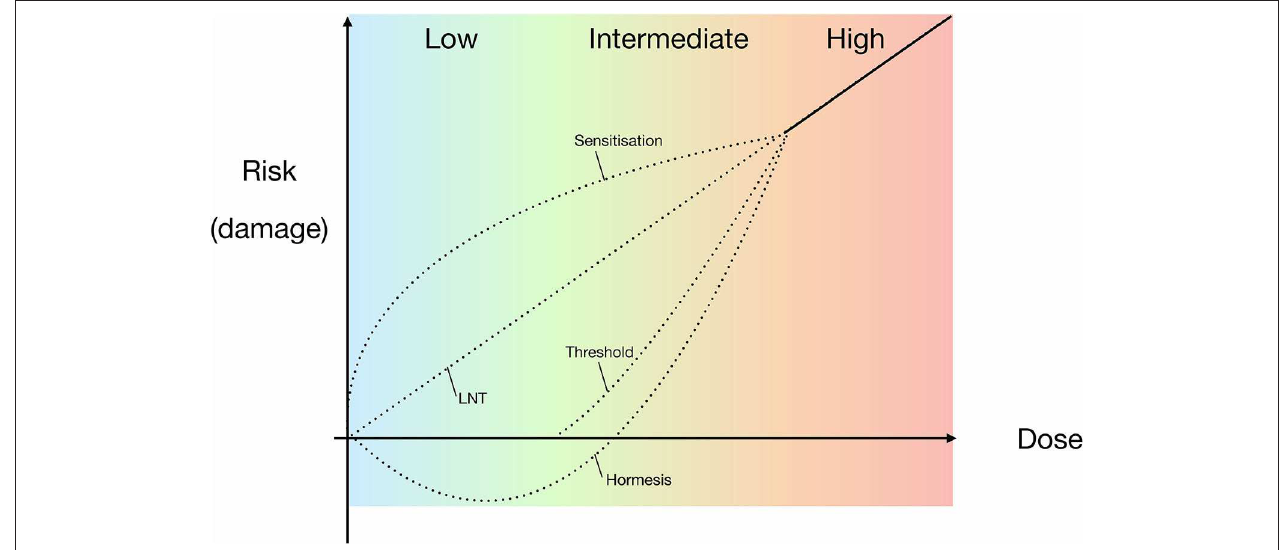
FIGURE 1 | Proposed models for experimental and theoretical correlations of radiation dose and the risk of damage to organisms, including the widely accepted LNT model. Models are based on high-dose data, extrapolating responses for lower dose ranges. High doses are defined as those causing observable, serious or irreparable damage to an organism. The dotted lines indicate the potential models that may be applicable to prokaryotes in the intermediate and low radiation does ranges, i.e., either side of background radiation up until high doses. LNT = linear relationship between dose and risk of damage to an organism; sensitivity = a heightened risk of damage at lower doses; hormesis = high dose inhibition with low dose stimulation; threshold = no/negligible risk of damage below a specific